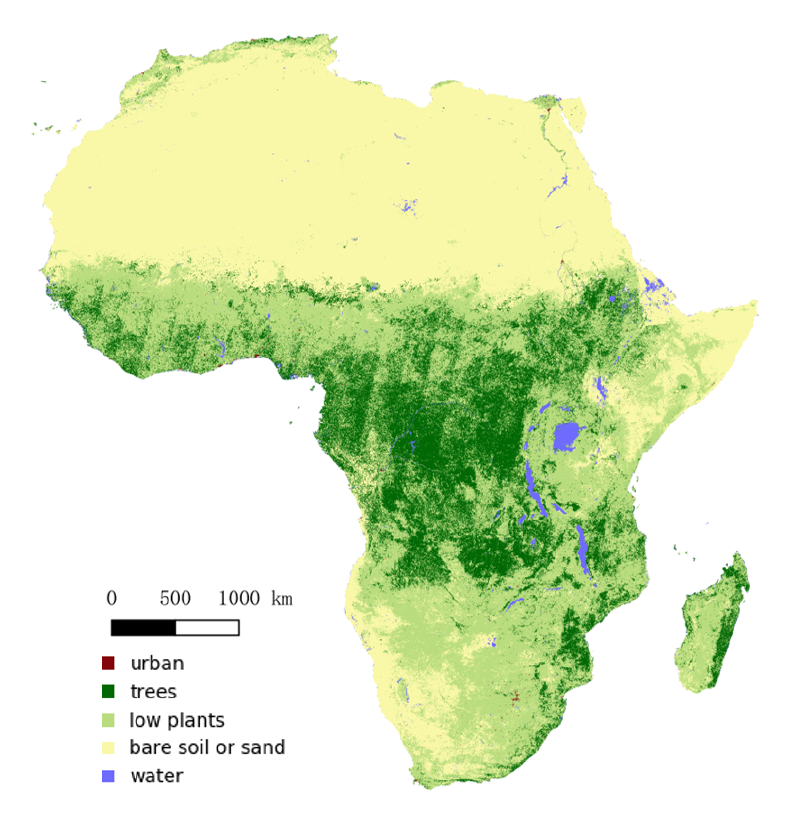
Figure 9. Visual mapping results of the whole continent of